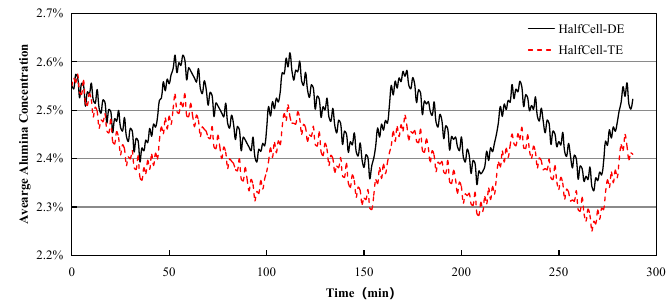
Figure 6. Variation of average alumina of half-cells under five cycles.